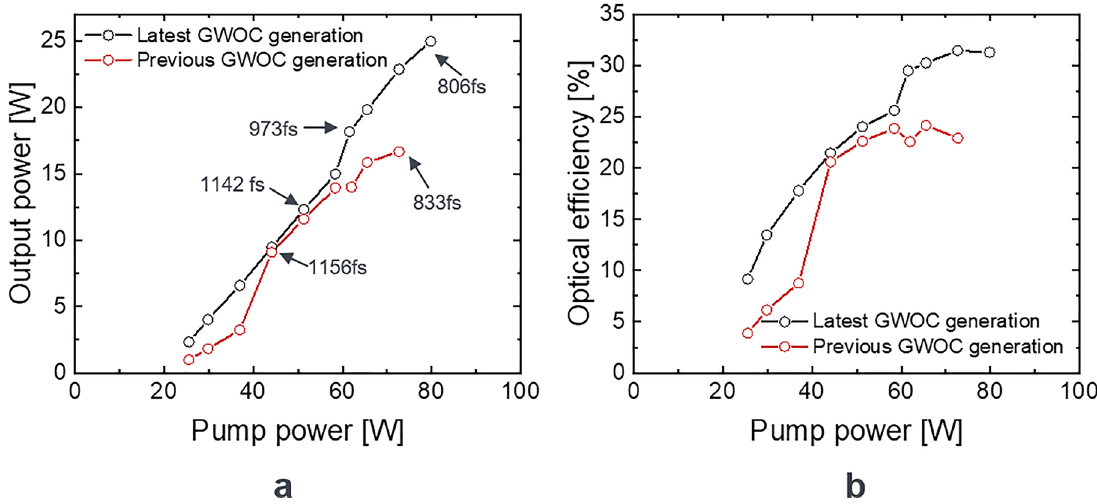
Figure 12: Laser output power (a) and optical ef fi ciency (b) using the GWOCs in a mode-locked thin-disk